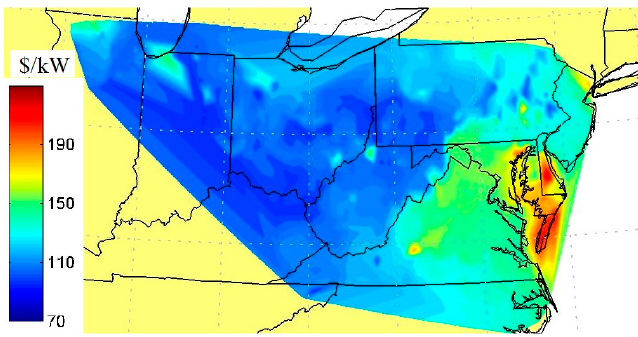
Figure 18. The variation of potential revenue in RTM for 2014 with 7395 PJM node locations.